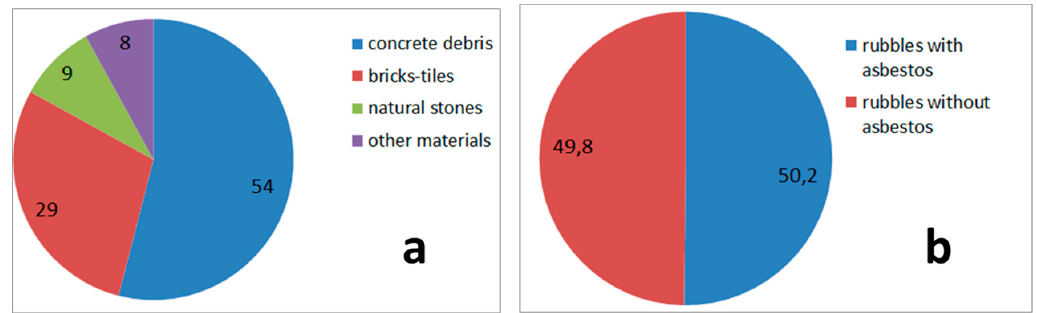
Figure 11. Data of table 7 show the main constituents’ percentages of m3 ( a ). Even if asbestos is detected within five of the fourteen considered rubbles heaps, it can be found within almost 50% of the entire volume ( b ; Table7).